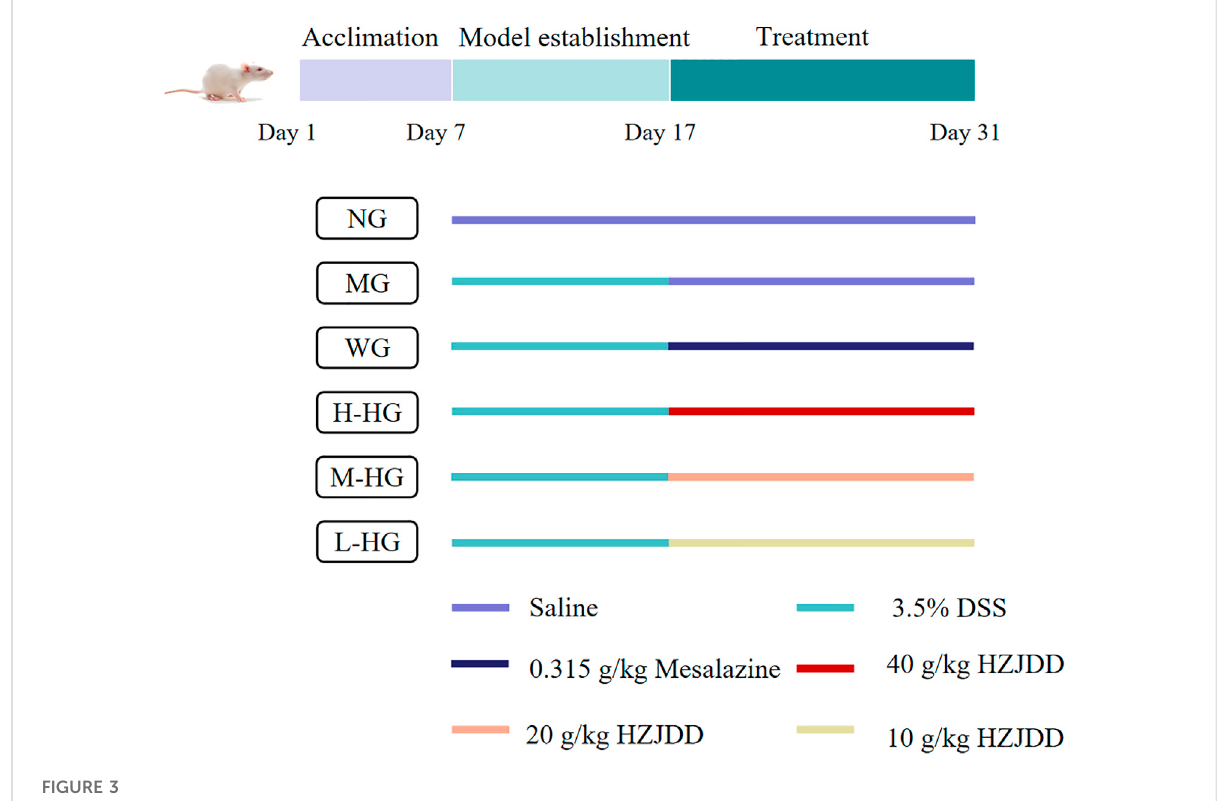
FIGURE 3 The experimental design